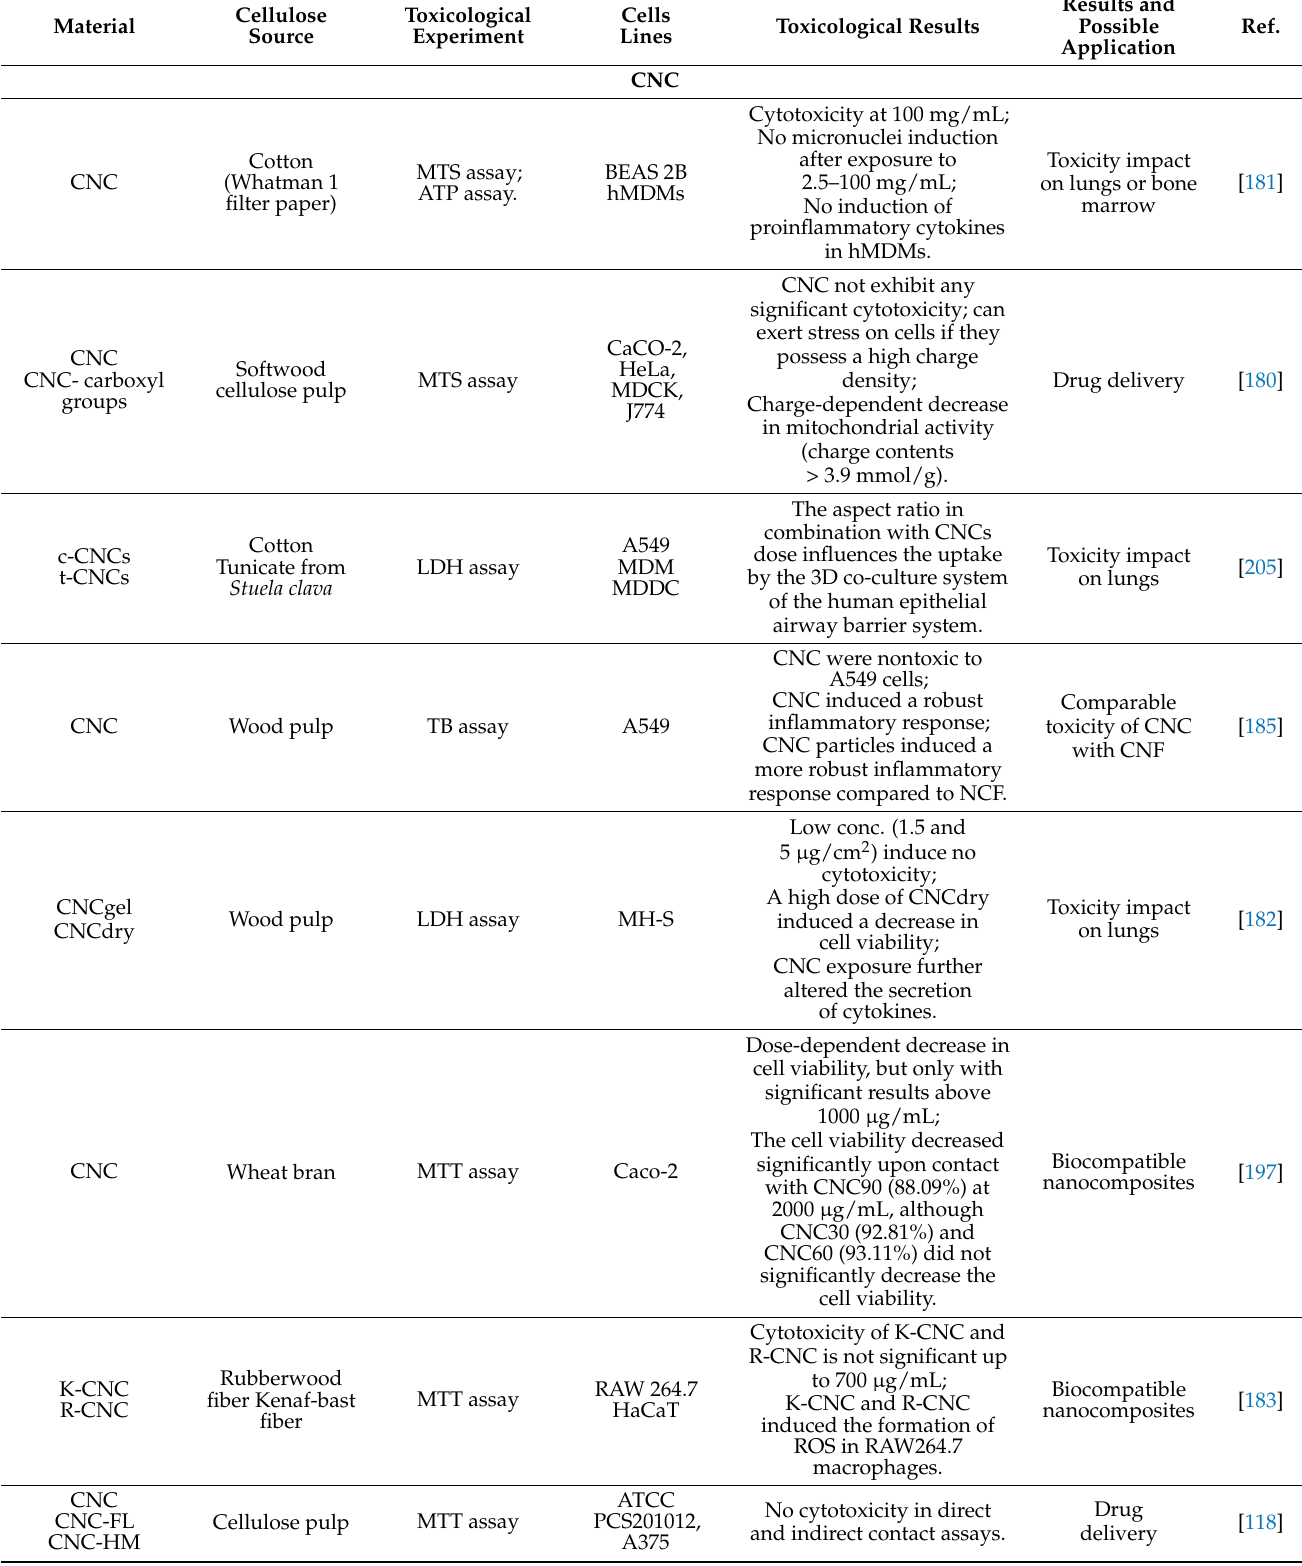
Table 4. Cytotoxicity evaluations in in vitro studies induced by CNC- and CNC-based materials.